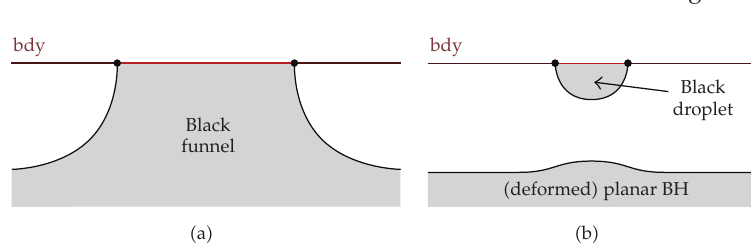
Figure 6: A sketch of our two novel classes of solutions dual to a deconfined phase of a strongly coupled field theory on a black hole background: (cid:3) a (cid:4) black funnel and (cid:3) b (cid:4) black droplet above a deformed planar black hole. The shaded part indicates regions which are behind horizons in the bulk spacetime, and the thick (cid:3) red (cid:4) line indicates the black hole of the boundary